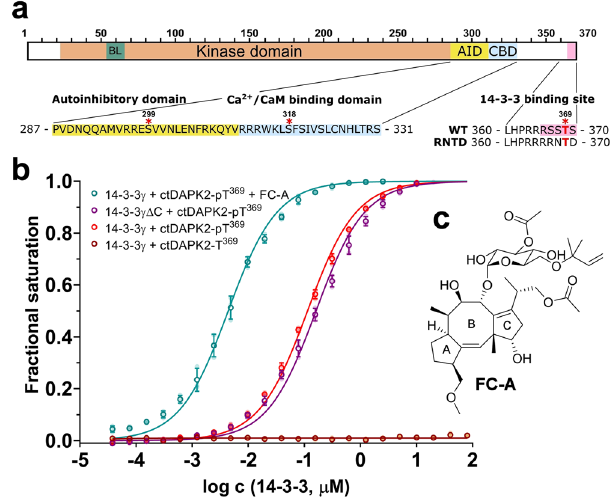
Fig. 1 The C terminus of DAPK2 binds to 14-3-3 via a mode III binding motif. a Domain structure of human DAPK2. BL basic loop, AID autoinhibitory domain, CBD Ca 2 + /CaM-binding domain. The positions of the (auto)phosphorylation sites Ser 299 , Ser 318 , and Thr 369 , and the sequence of the DAPK2 RNTD mutant C terminus are indicated below. b Fluorescence polarization (FP) measurements of FAM-labeled ctDAPK- pT 369 peptide with and without 100 μ M Fusicoccin A (FC-A) titrated by 14- 3-3 γ (or 14-3-3 γΔ C). The binding af fi nities were determined by fi tting the FP data to a one-site-binding model, with 161 ± 7, 114 ± 3, and 4.4 ± 0.2 nM apparent K D for ctDAPK2-pT 369 peptide binding to 14-3-3 γΔ C, 14-3-3 γ , and 14-3-3 γ + FC-A, respectively. All data points are the mean ± SD of three replicates. c FC-A